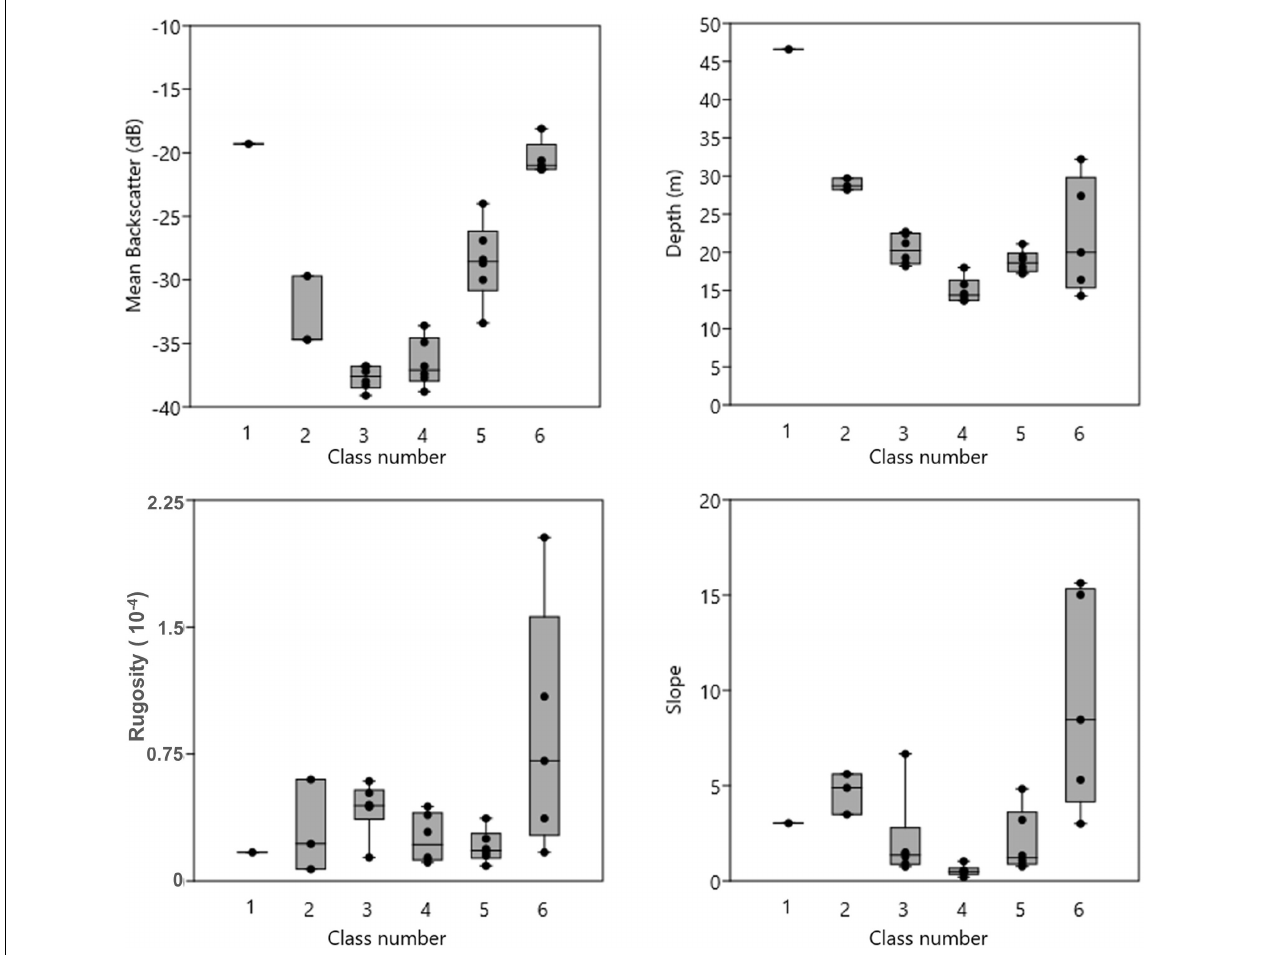
FIGURE 4 | Boxplots showing the pre-normalised values of the MBES parameters used in the Unsupervised Iso-cluster Classification. Individual grab samples have been grouped by